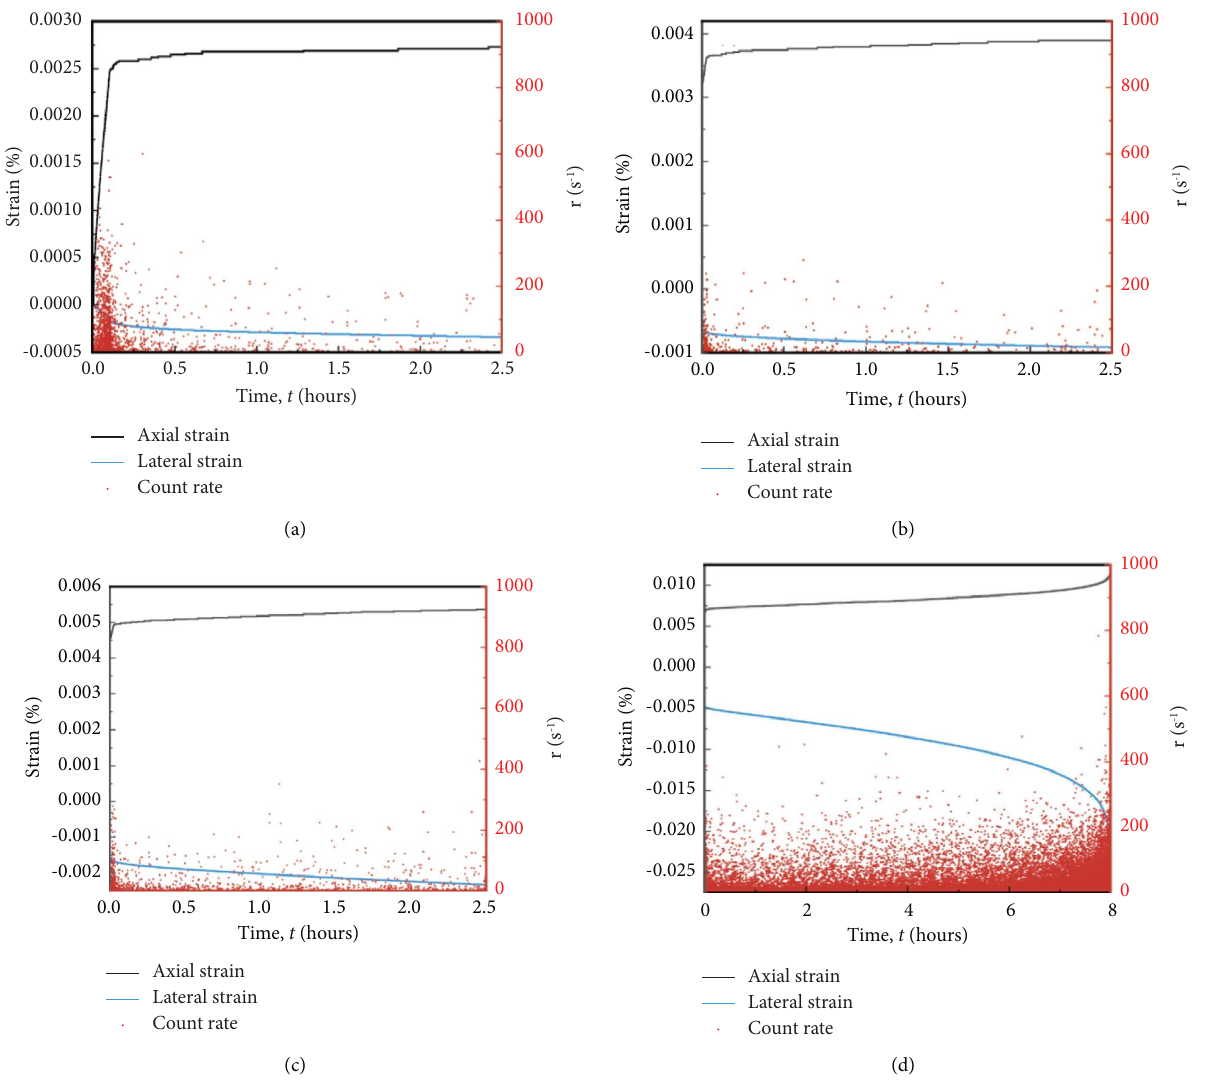
Figure 10: Te relationship between the loading time, strain, and AE signal of the natural sample at each loading stage. (a) 0.4 σ . (d) 0.7 σ (c) 0.6 σ ucs ucs